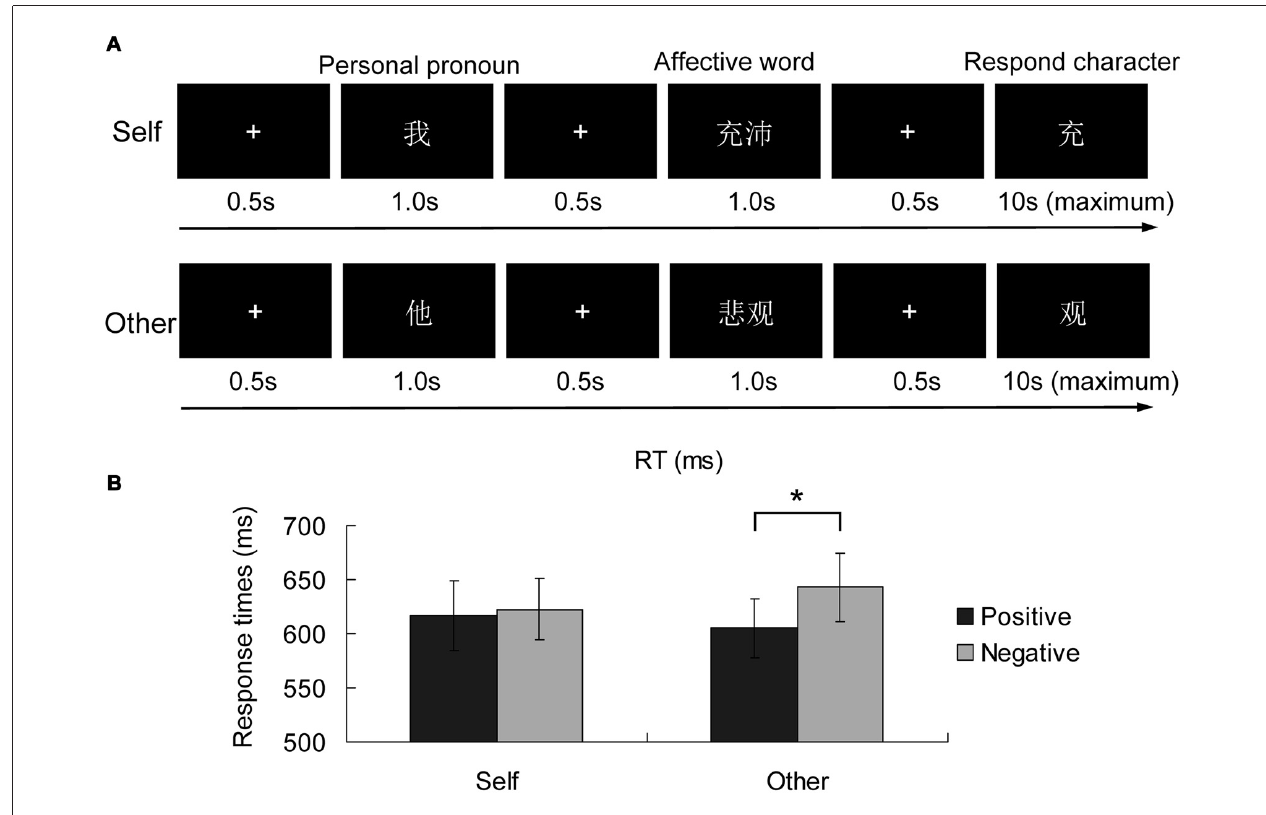
FIGURE 1 | Implicit self-referential emotion task procedure (A) and the response times (RTs) in the experimental conditions (B) . After a self-referential or non-self-referential pronoun word appeared, a positive or negative personality trait word was shown on the screen, and participants were asked to judge the order of the following character in the affective word. The black and gray bars indicate the self-reference and other-reference conditions respectively. The error bars are the standard errors in each condition. ∗ p <